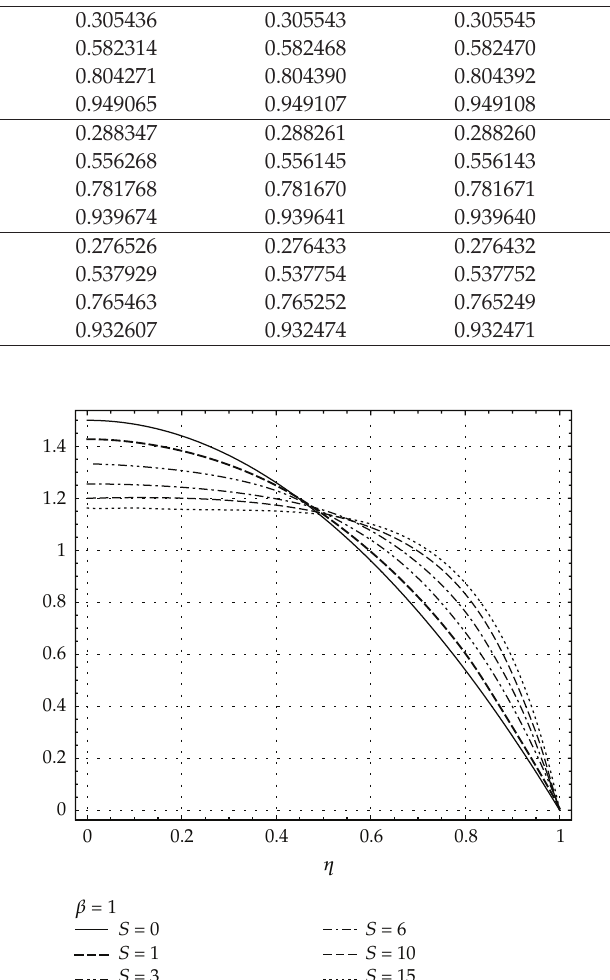
Figure 2: The influence of positive S on f (cid:2) (cid:3) η (cid:4) for the two-dimensional